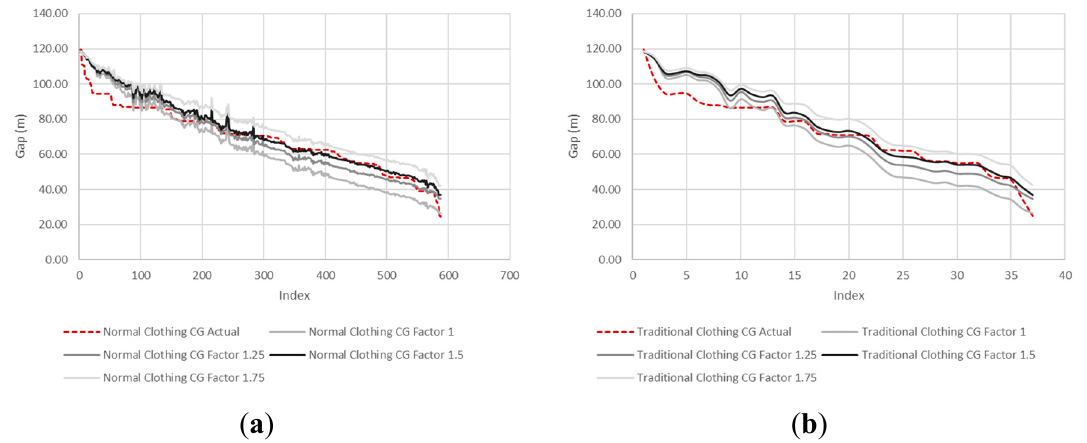
Figure 7. Comparison between actual data and simulation results per type of clothing. ( a ) Normal clothing; ( b ) traditional clothing.